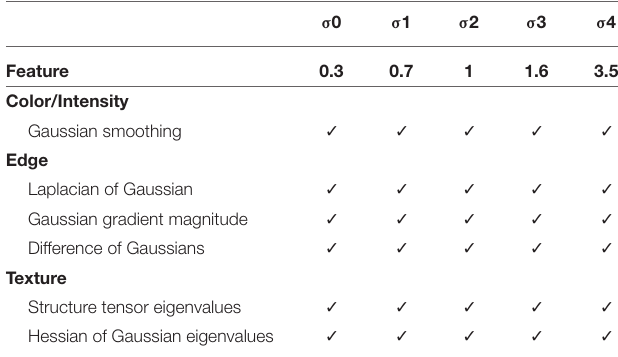
TABLE 5 | Features selected for segmentation for the different datasets using